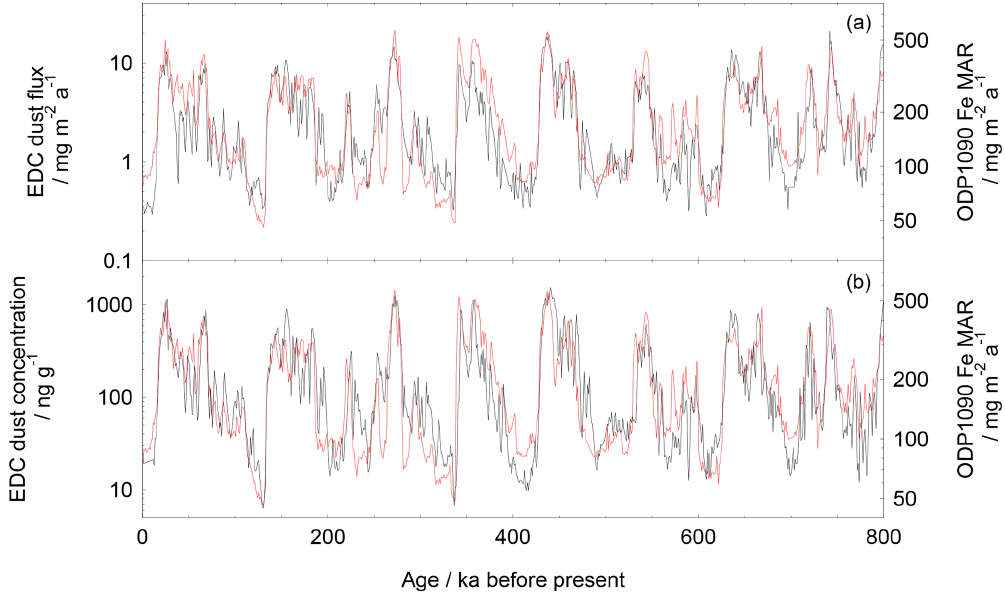
Figure 5. Ice core and marine sediment dust data for the past 800kyr. EDC dust (black) (Lambert et al., 2008); Fe MAR from ODP site 1090 (red) (Martinez-Garcia et al., 2011). Panel (a) uses EDC dust flux, while panel (b) uses EDC dust concentration. Data have been smoothed to 1kyr averages, and the marine data were aligned (Martinez-Garcia et al., 2011) to the ice core age